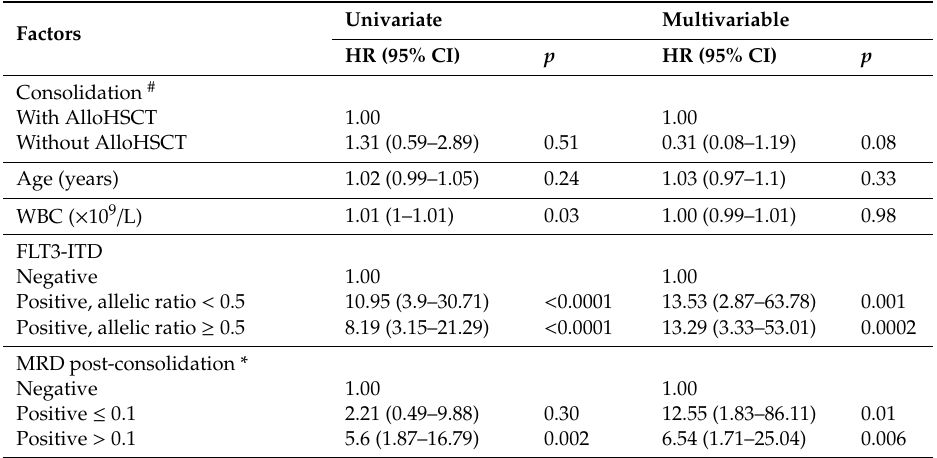
Table 2. Univariate and multivariable analysis for overall survival among 86 patients in complete remission (CR) after